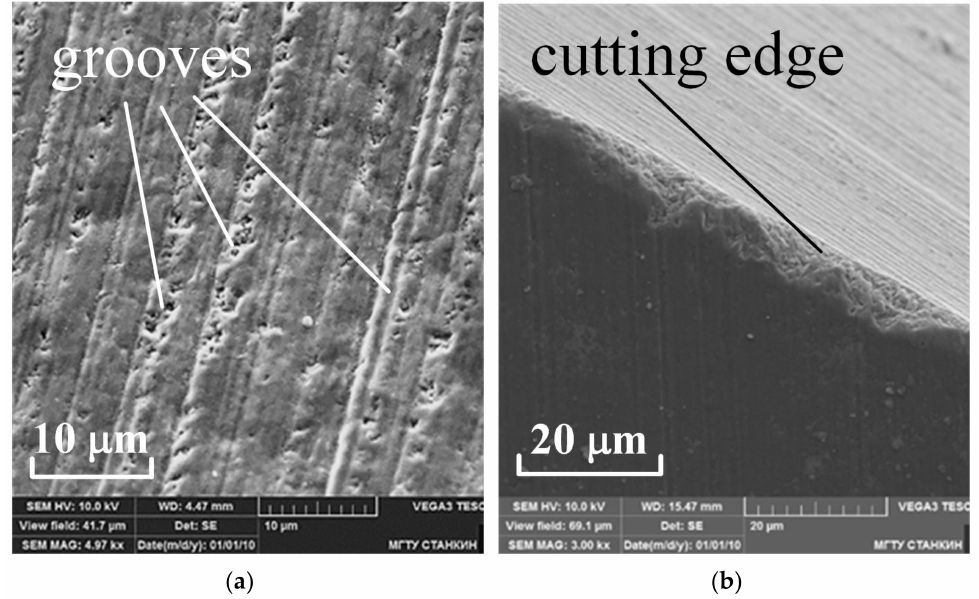
Figure 1. SEM images of a cutting plate made of SiAlON ceramics; ( a ) deep grooves profiled with single diamond grains: ( b ) defects on the cutting